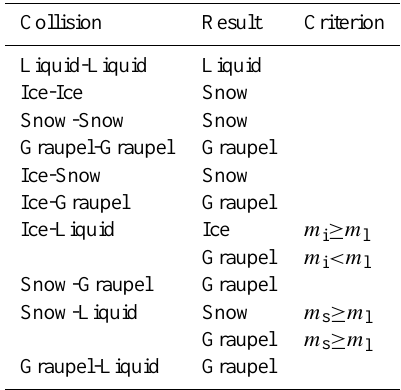
Table 1. Assumptions regarding hydrometeor